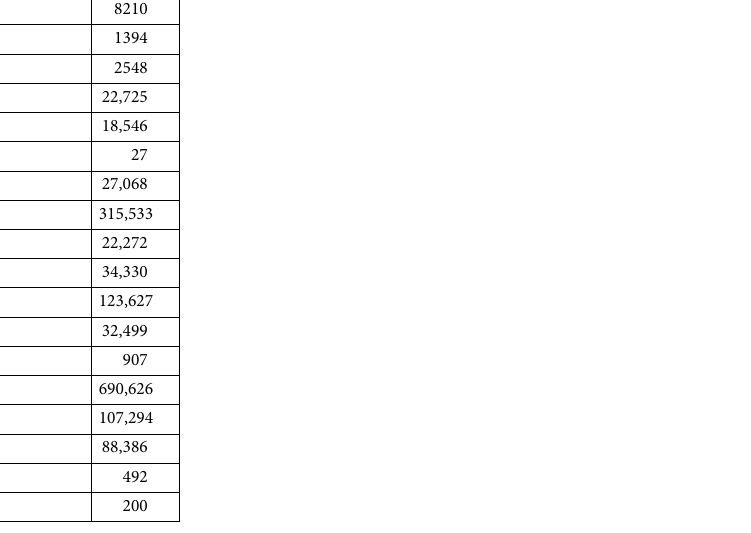
Table 1. Statistics of node types in CTKG